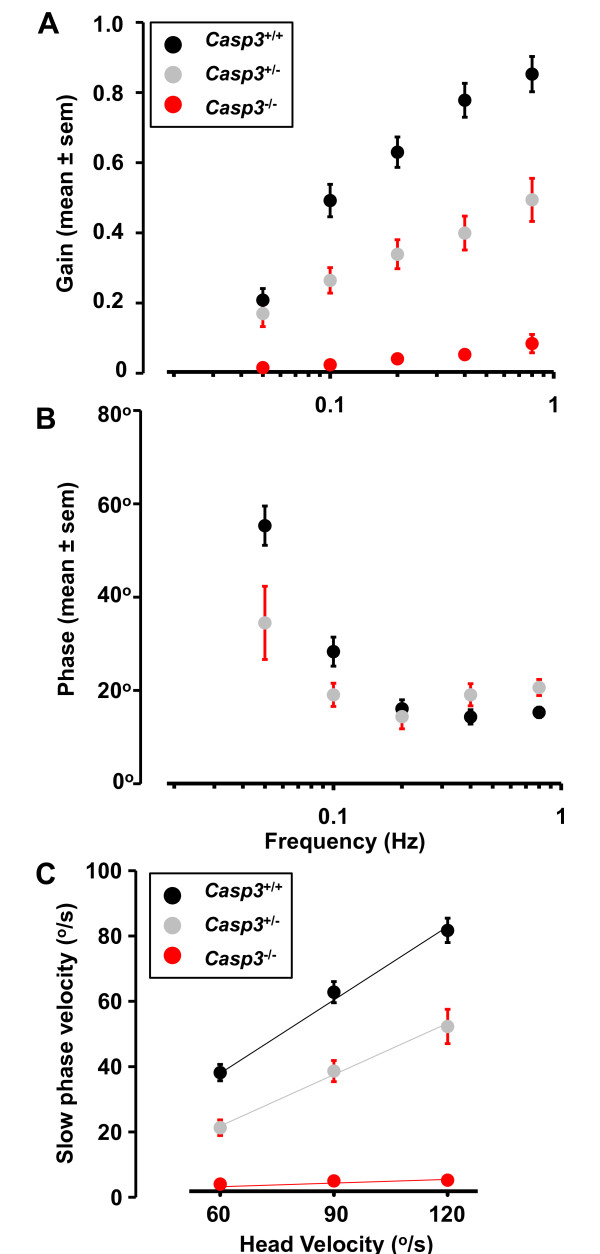
Vestibular ocular reflex (VOR) in caspase-3 deficient mice. VOR in darkness. Gain (A) and phase (B) at different frequencies were compared among all genotypes. Negligible VOR responses were recorded for Casp3-/- mice at all stimulus conditions. Heterozygous Casp3+/- mice performed at an intermediate level compared to wild type Casp3+/+ mice, with VOR impairment at higher frequencies. (C) VOR linearity at 0.2Hz. The sensitivity (increase in SPV for increase in head velocity) was reduced for the heterozygous Casp3+/- group, and negligible for the knockout Casp3-/- group. Black circle, Casp3+/+. Gray circle, Casp3+/-. Red circle, Casp3-/-. SPV, slow phase velocity.